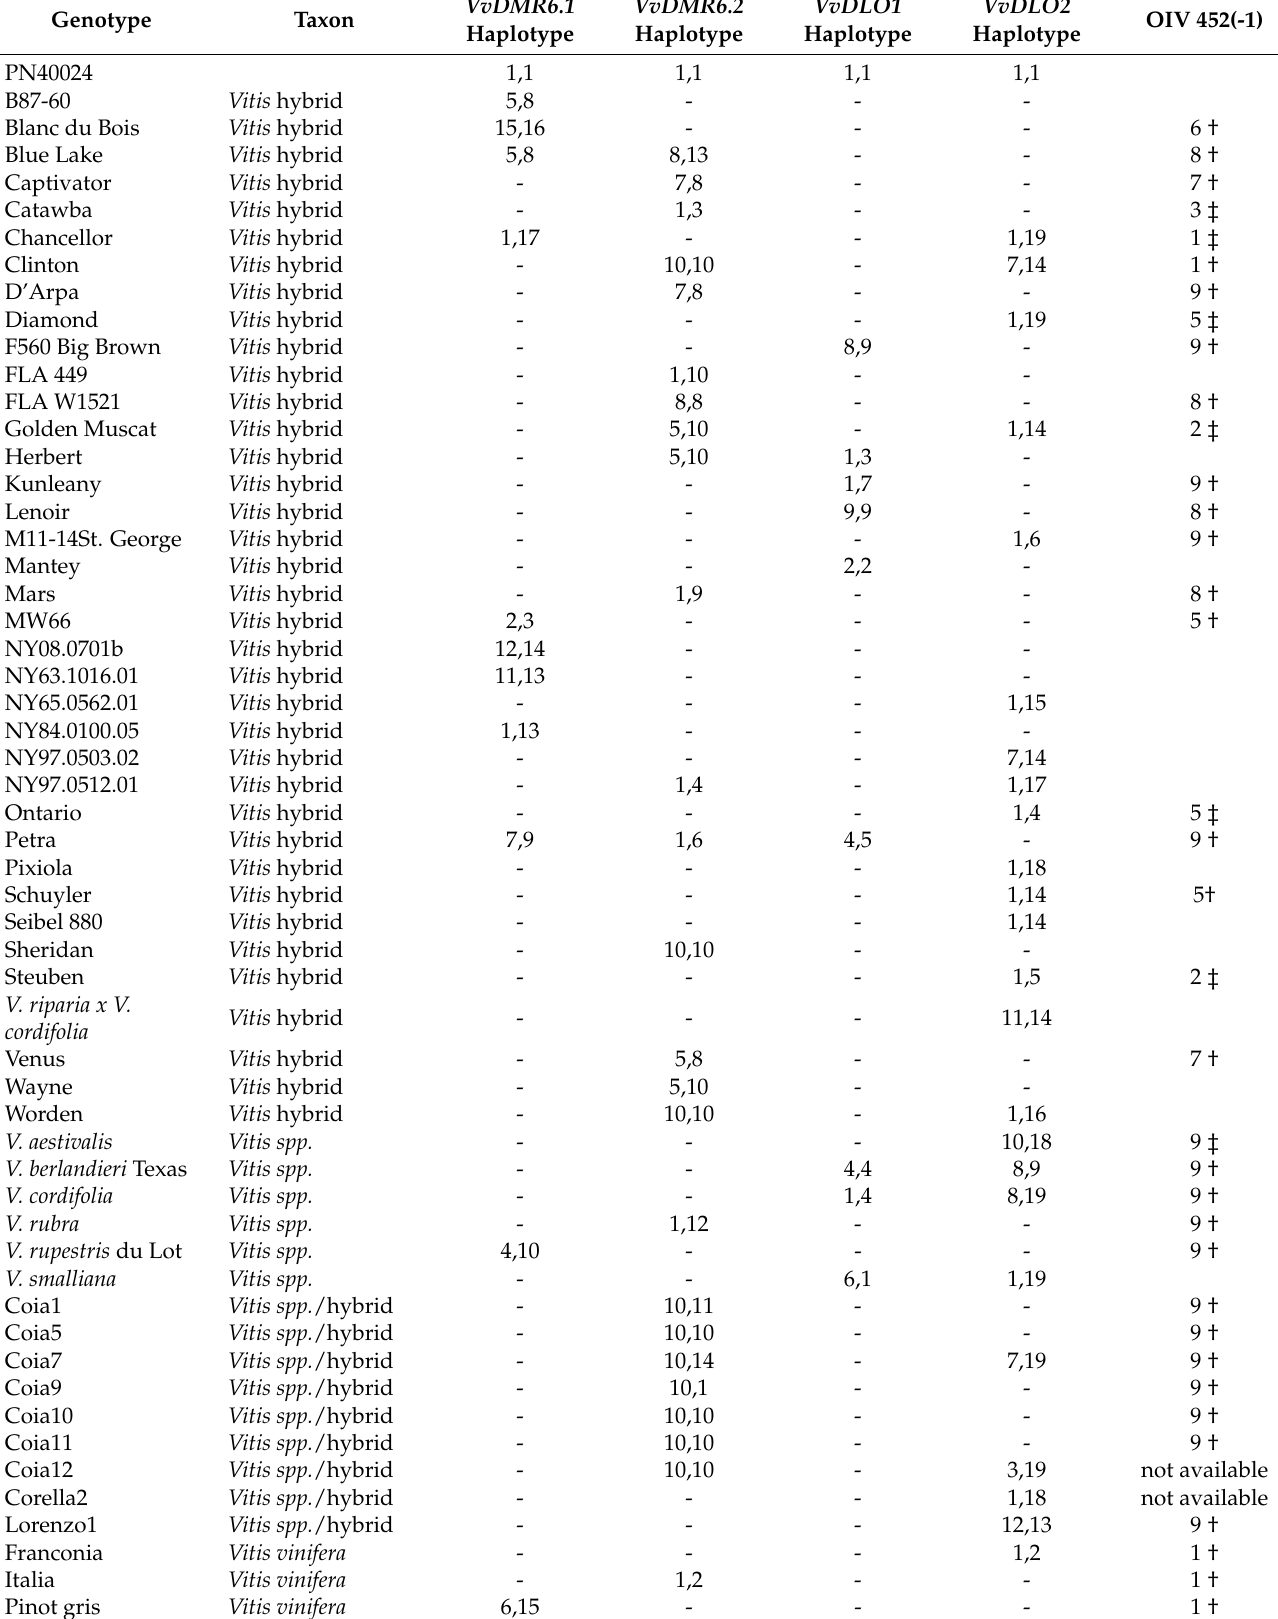
Table 2. Example of the haplotypic structure for each analyzed